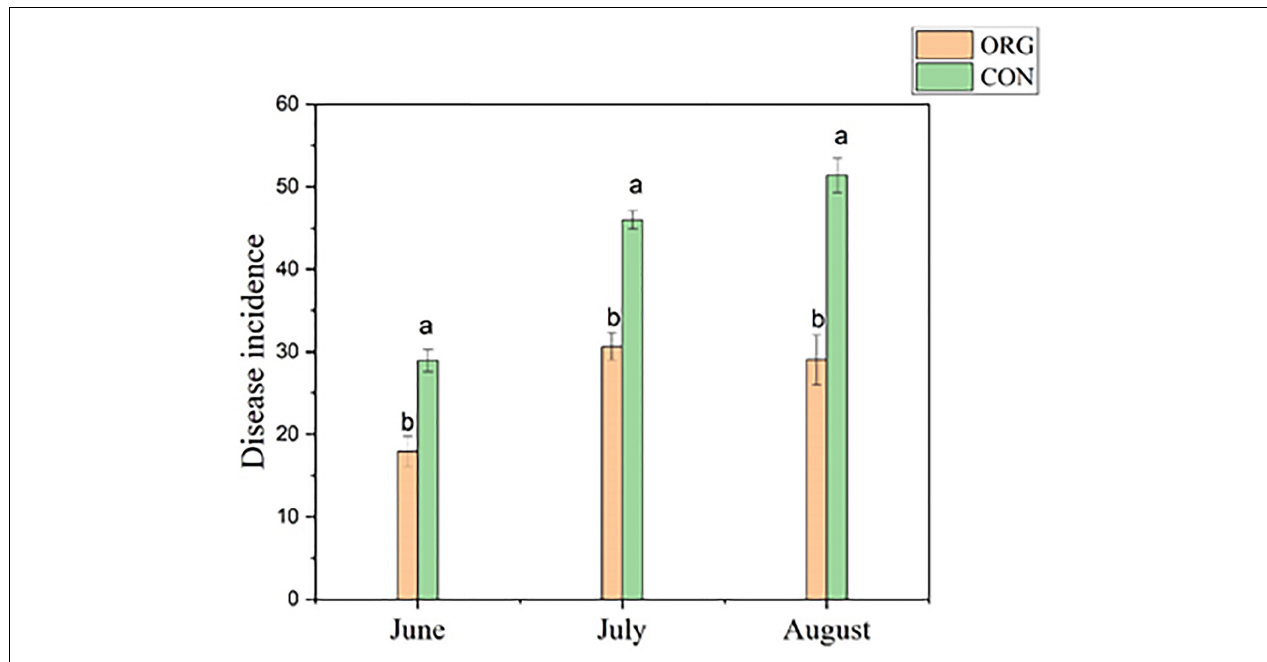
FIGURE 2 | Tomato Fusarium wilt disease incidence from June to August in 2019 during the field experiment ( N = 15).